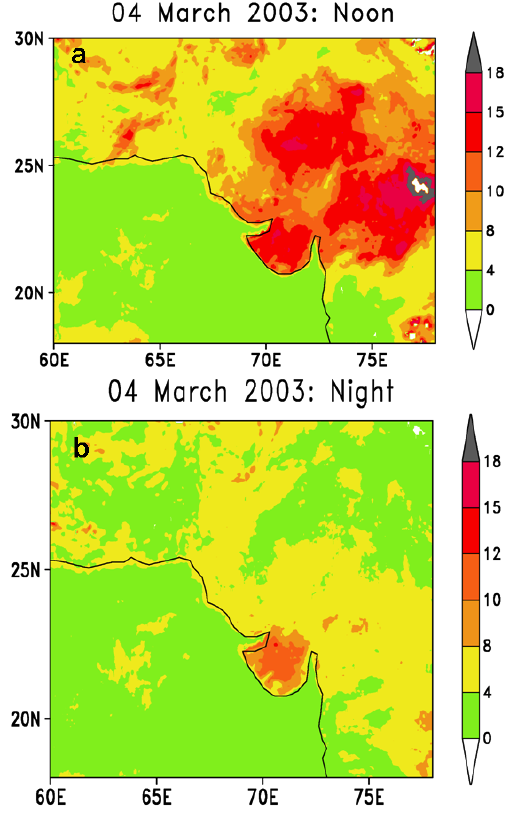
Fig. 2. (a) An example of IDDI image over the Indian “Thar” desert 4 March 2003. (b) Corresponding image for night of same day.